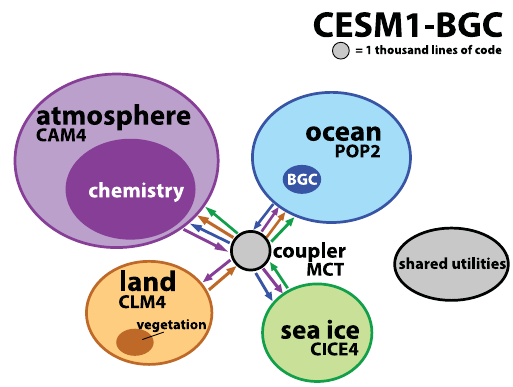
Figure 3. Architecture diagram for GISS-E2-R-TCADI.